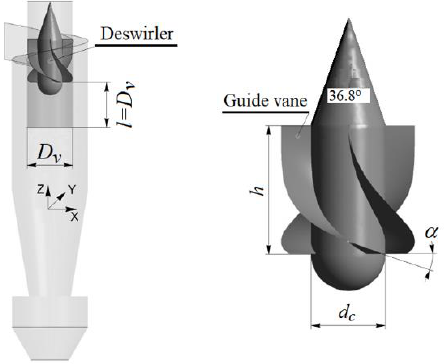
Figure 15. Deswirler geometry and dimensions: D v — vortex finder diameter, l — mounting height in the vortex finder, d c — deswirler core diameter, h — height of guide vanes and α— leading edge angle. Figure made by author based on data from paper [82].